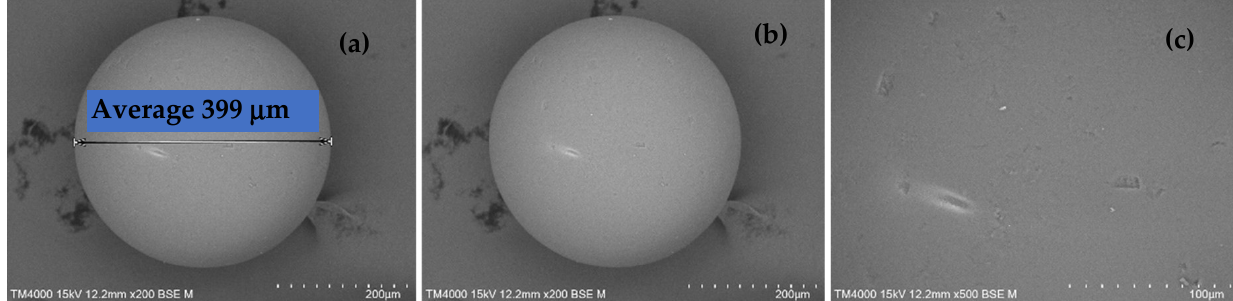
Figure 2. High-magnification SEM images of Cu(II)-loaded H + Dowex-M4195 chelating resin at a magnification of ×200; ( a ) average dimensions, ( b ) spherical form and ( c ) the surface of resin.